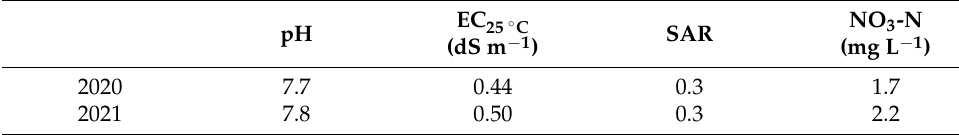
Table 3. Irrigation water quality parameters in 2020 and 2021.